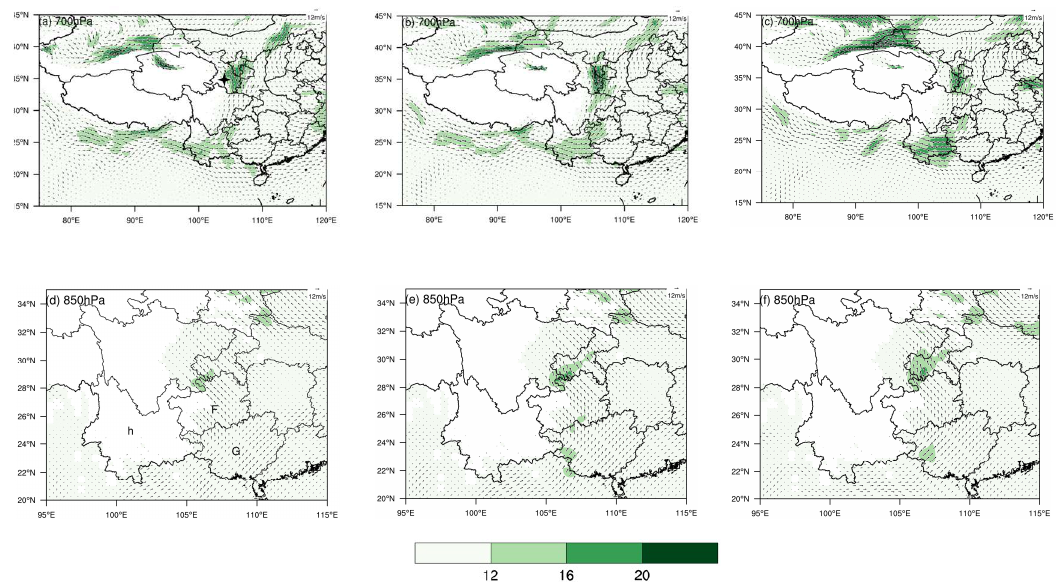
Figure 3. Distributions of wind fields at 700 hPa (vectors, m·s −1 ), LLJ (shading indicates wind speed over 12 m·s −1 ) and distribution of wind fields at 850 hPa (vectors, m·s −1 ), LLJ (shading indicates wind speed over 12 m·s −1 ) at 1500 UTC 1 May ( a , d ), 1900 UTC 1 May ( b , e ), and 2300 UTC 1 May ( c , f ). represent the Gansu province. F, G, and h represent the Guizhou province, Guangxi Provence and Yunnan province, respectively.